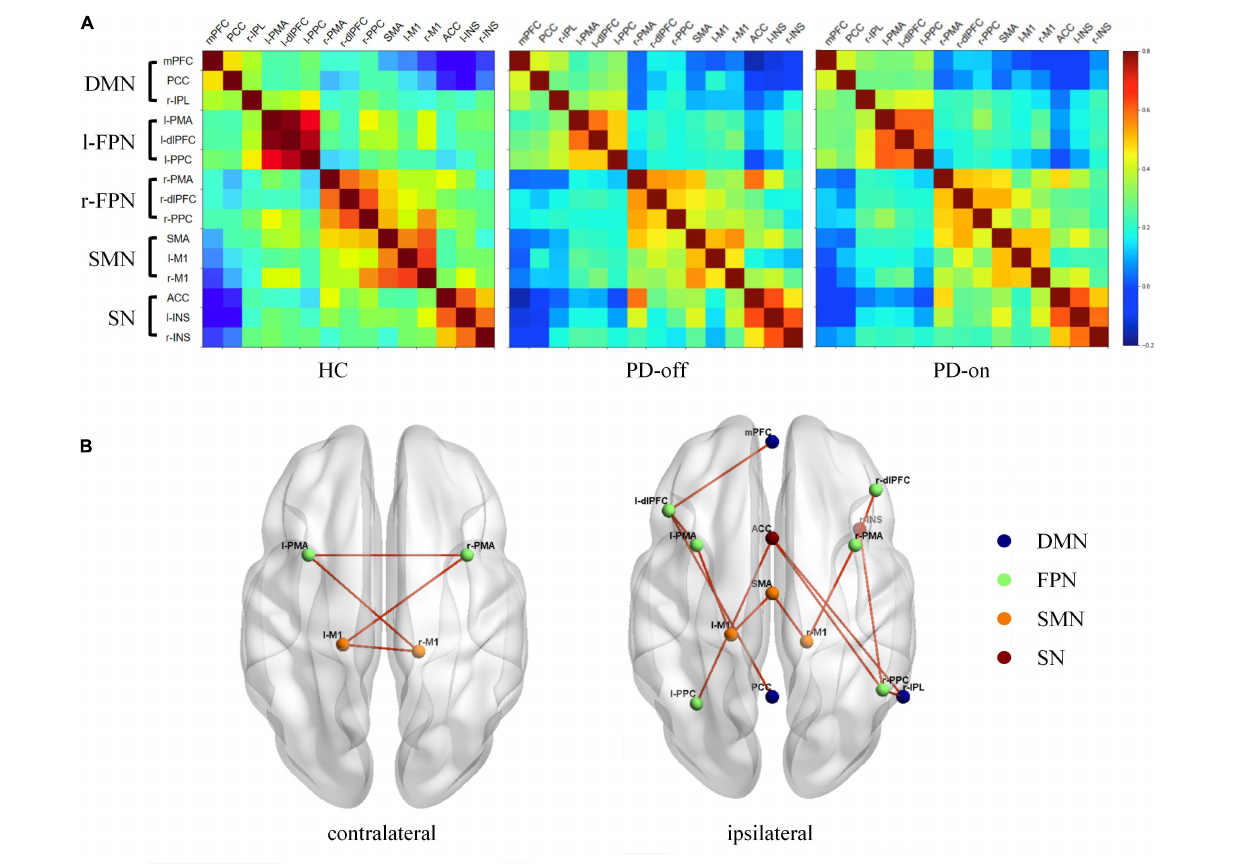
FIGURE 3 | Different functional connectivities of selected regions of interest (ROIs) among HC, PD-off, and PD-on. (A) Functional connectivity matrix from selected ROIs for HC, PD-off, and PD-on. The color bar indicates the correlation coefficients between ROIs on the right. (B) Different functional connectivities of contralateral (left) and ipsilateral (right) among the three groups are shown separately in the three-dimensional view from the superior perspective. Spheres are shown as ROIs from networks with legends in the right. Lines denote significant differences ( P < 0.05,